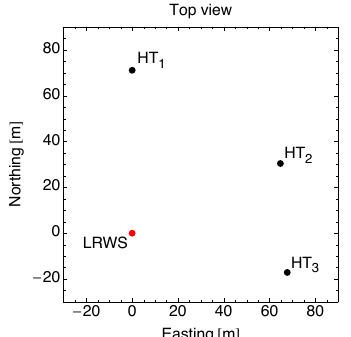
Figure 14. Static pointing accuracy test of LRWS using three survey poles denoted HT 1 , HT 2 and HT 3